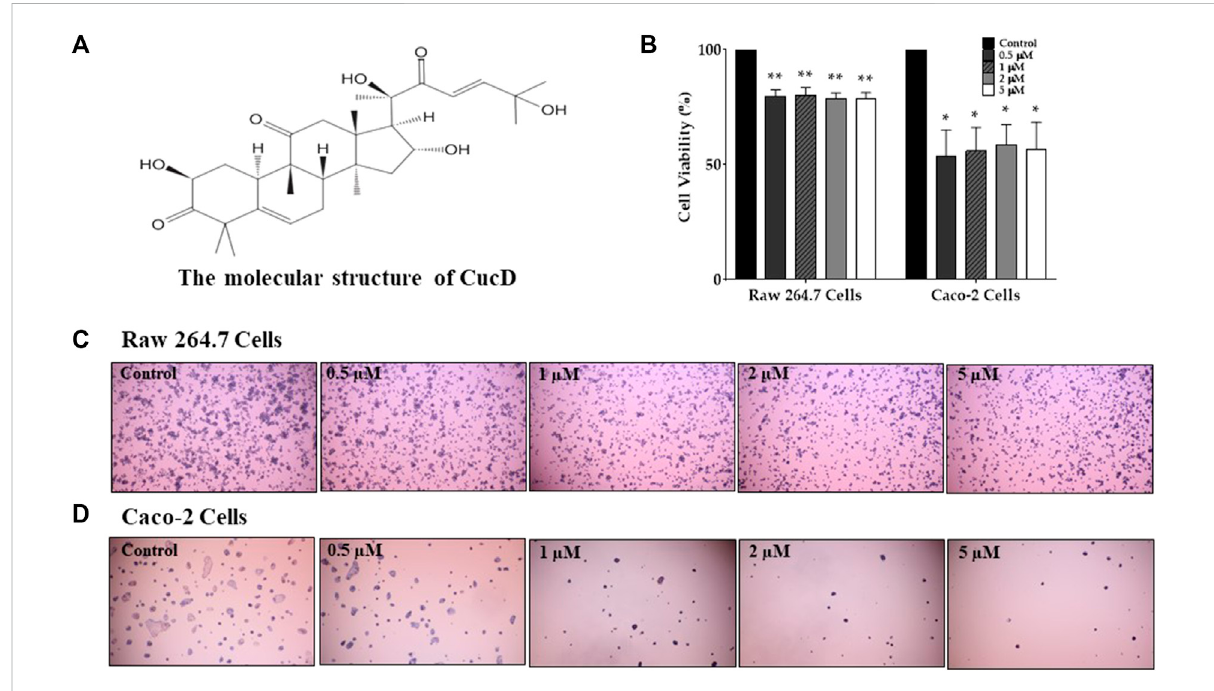
FIGURE 5 Assessmentofthecytotoxiceffectof cucurbitacinD(CucD).The chemicalstructure ofCucD (A) . The effect offour differentdoses ofCucD (.5, 1, 2, and 5 µM) on the viability of RAW 264.7 and Caco-2 cells (B) and their morphologies (C and D) . Data were experiments and expressed as the mean value ± SD of three independent experiments. * p < .05 and ** p < .01 vs. control with one-way ANOVA.